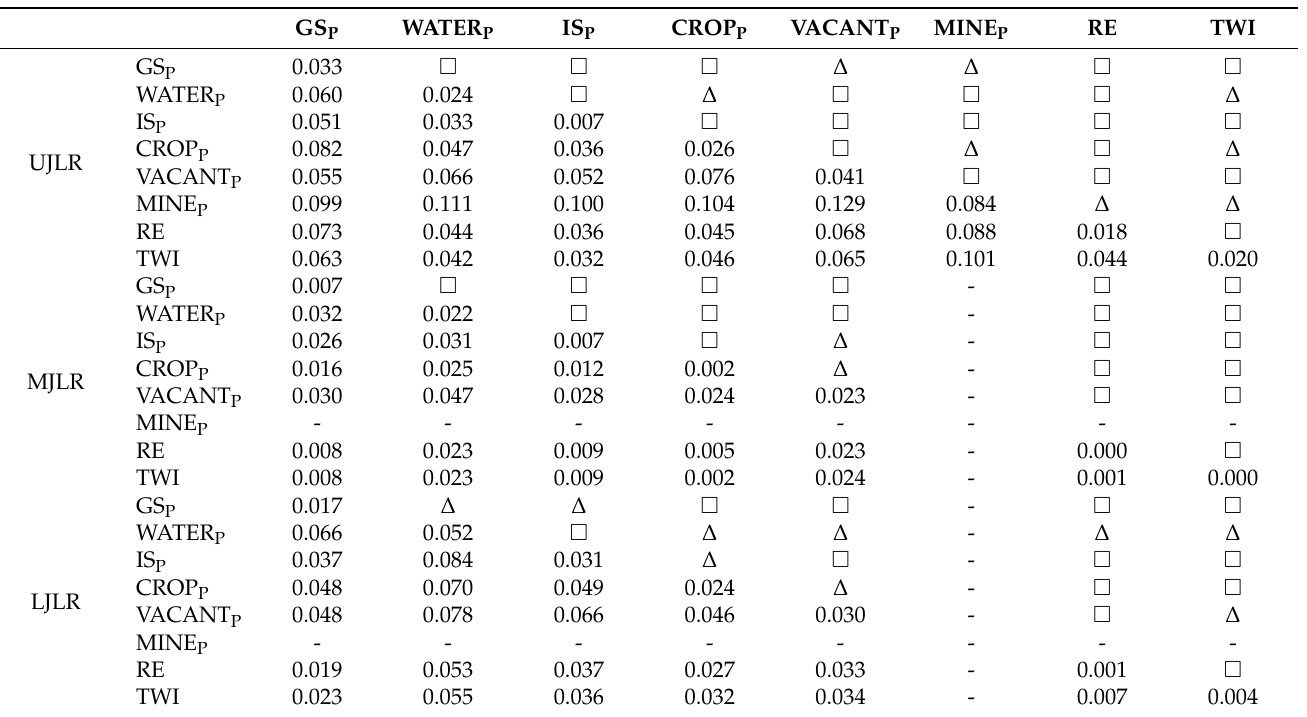
Table 5. Summary of interactive influences of the eight landscape characteristics indexes on flood inundation intensity along the Jialu